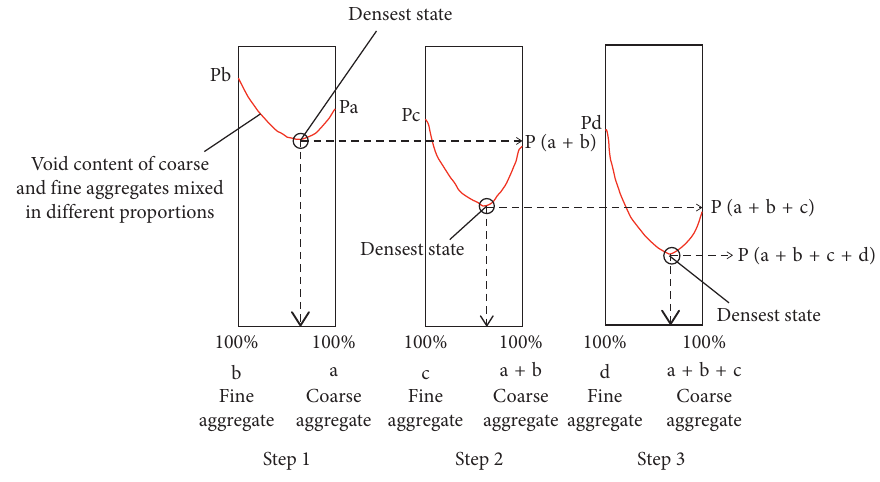
Figure 2: Mixing process of multi-particle-size